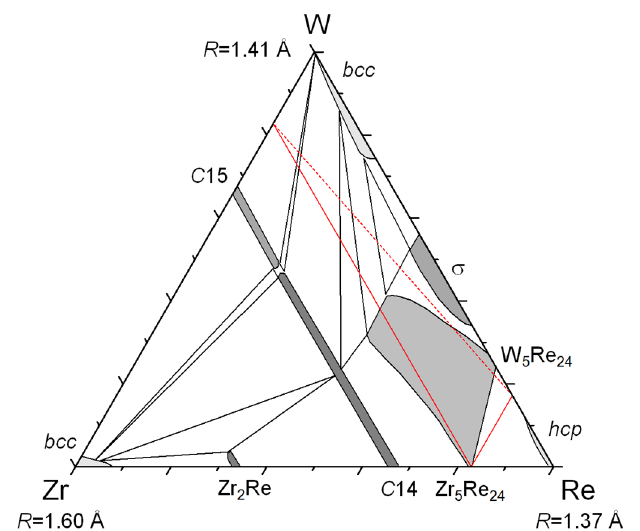
Figure 7. Isothermal section at 1350 °C of the Zr–W–Re system (redrawn from [16], Copyright 1970, Academy Science Ukraine). The red triangle shows the three ordered stable or metastable compositions of the χ phase, Zr 5 W 24 , Zr 5 Re 24 , and W 5 Re 24 , as in Figure 2 (solid lines: normal substitution, dashed line: site